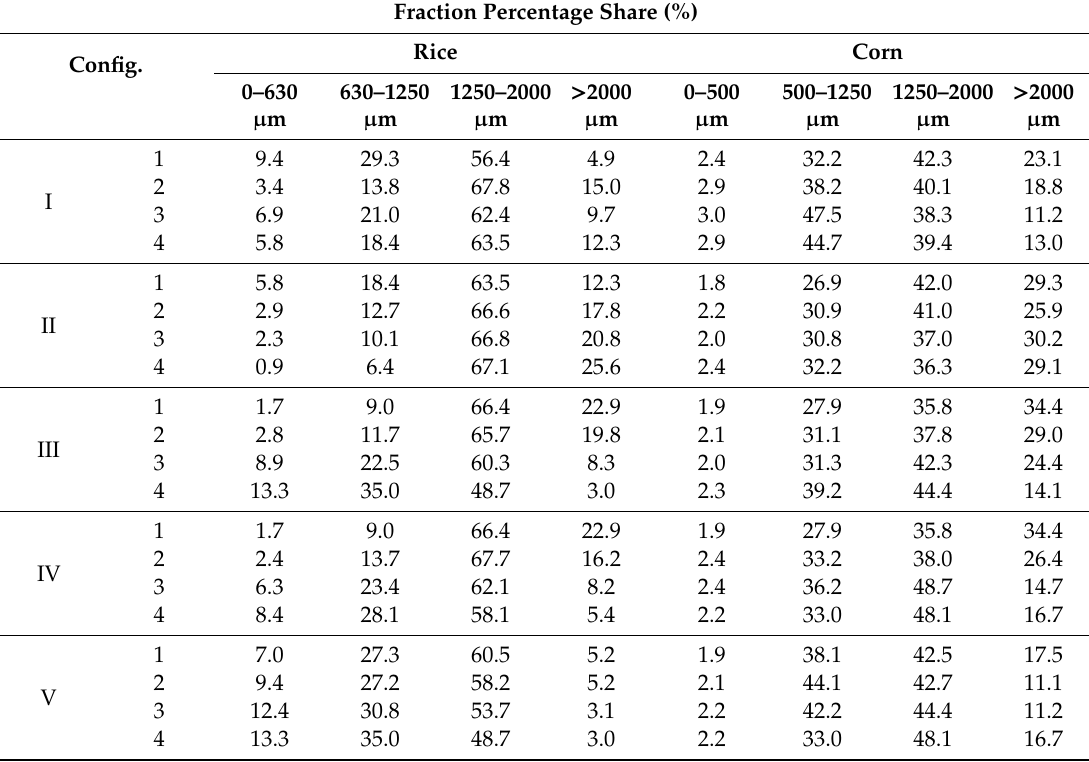
Table4. Granulometriccontentofbiomaterialaftergrindingfortheanalyzeddiscangularspeedsettings. Fraction Percentage Share (%) Rice Corn Config.